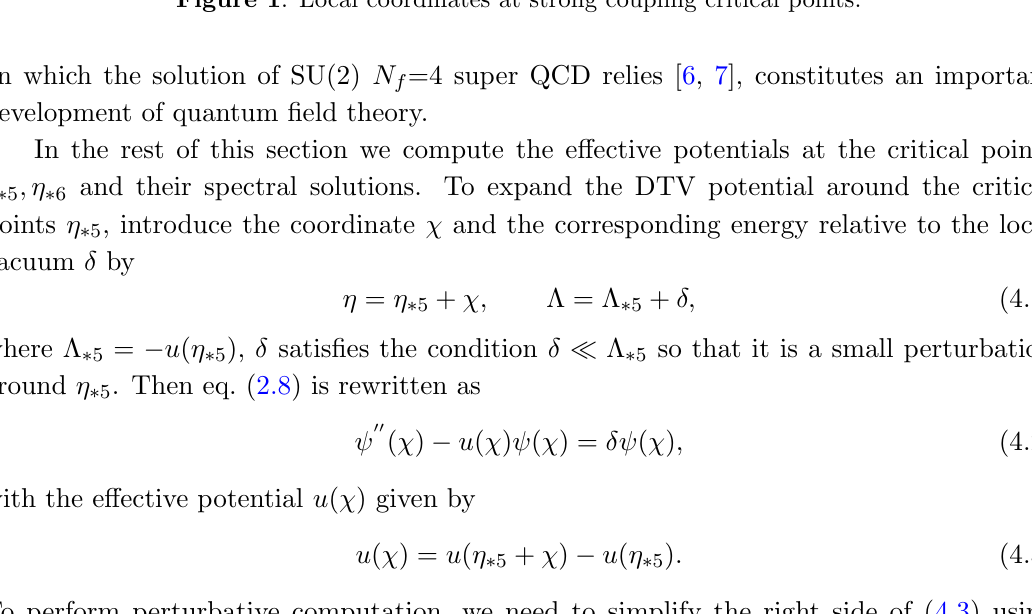
Figure 1 . Local coordinates at strong coupling critical